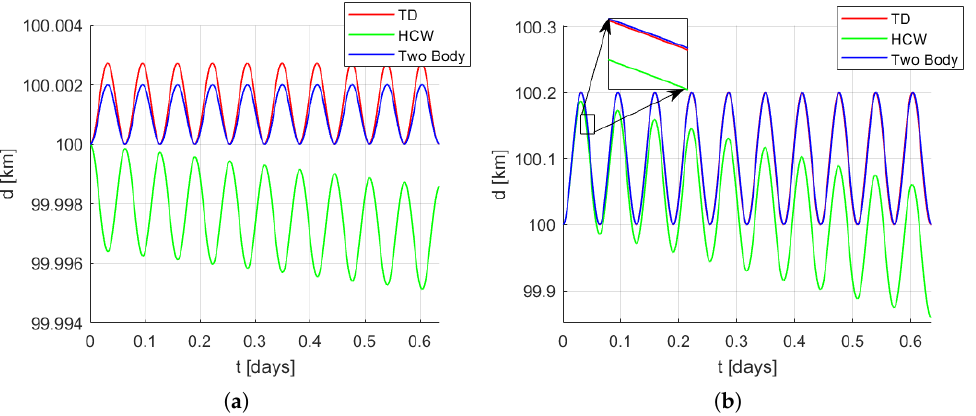
Figure 4. Inter-satellite distance for different eccentricities. ( a ) Eccentricity e = 10 − 5 . ( b ) Eccentricity e = 10 − 3